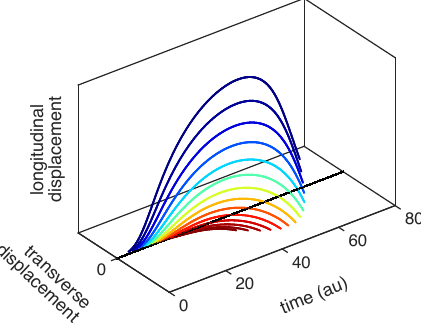
Figure 2. Short trajectories in two-colour HHG displacement gate. Some trajectories are displaced and miss the parent ion on the return, and others can come back to where they originated. The colour code corresponds to the kinetic energy carried by the electrons at the return, blue = high energy, red = low